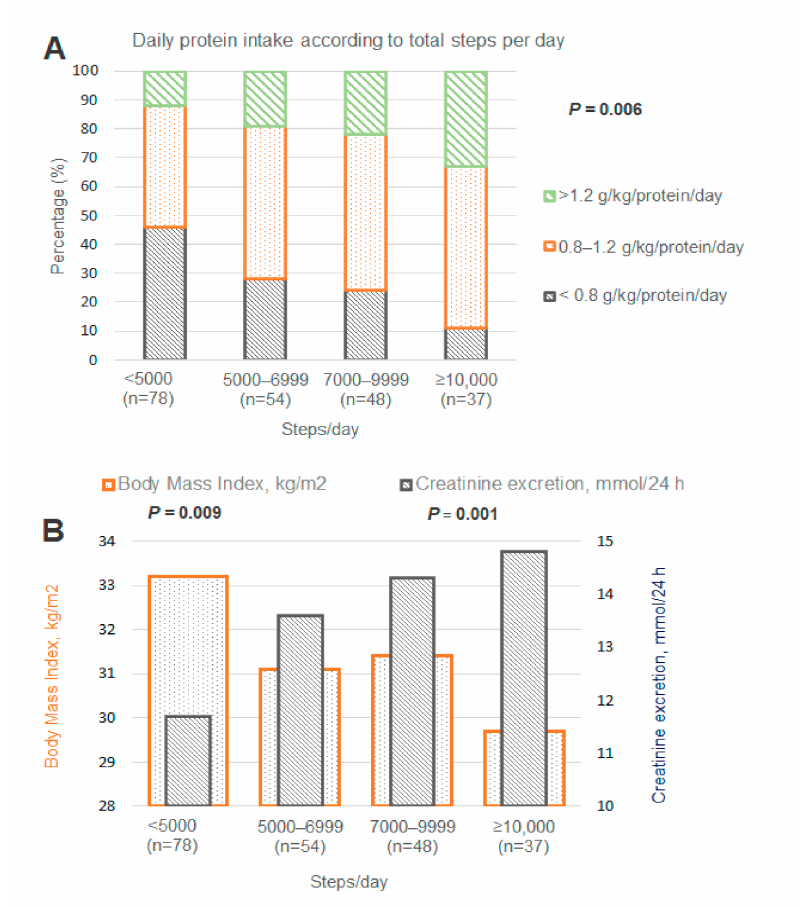
Figure 1. Protein intake, body mass index (BMI), and 24 h urinary creatinine excretion according to total steps per day. Distribution of total protein intake ( A ) and urinary creatinine excretion and